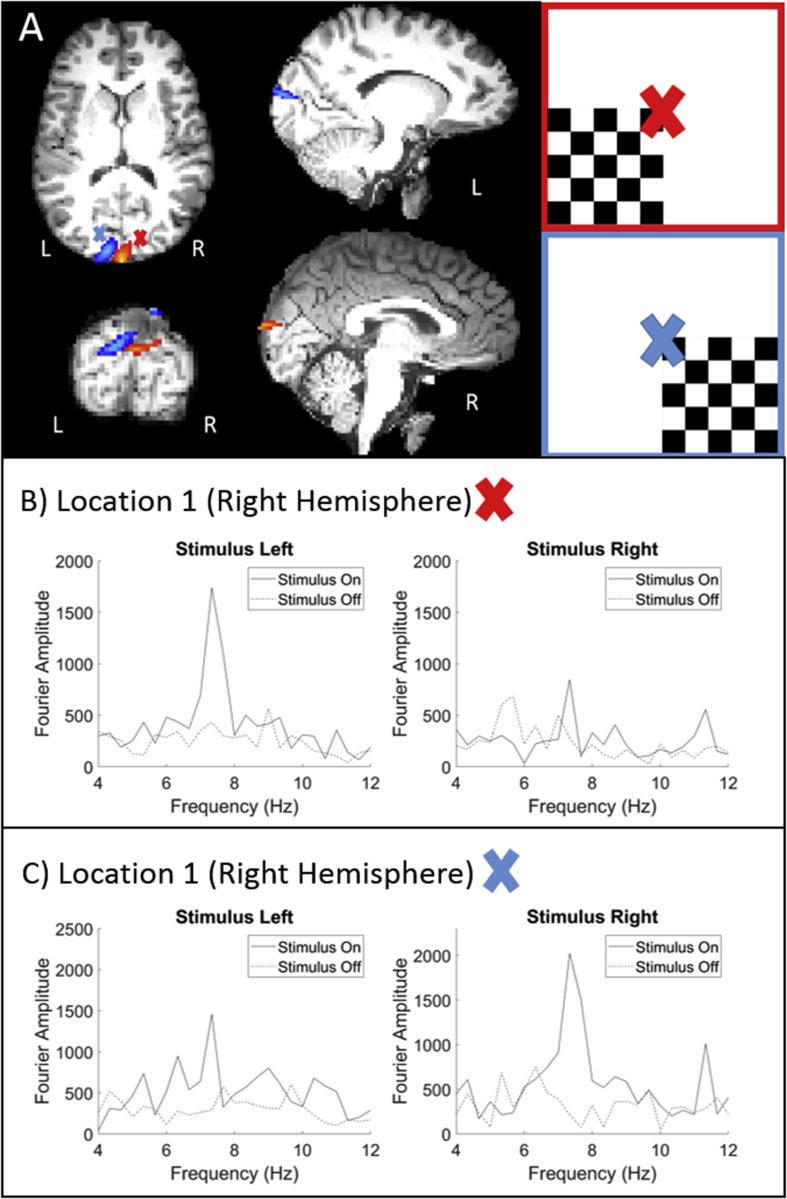
A) Pseudo T-stat images produced from the cases where the stimulus was in the left visual field (red cross, red overlay, subject view shown in red inset) or the right visual field (blue cross, blue overlay, subject view shown in blue inset). The images were thresholded between 1.5 and 1.8 and 1.1 and 1.6 for the red and blue images respectively. B) The Fourier transforms of virtual electrode time-courses compared during stimulation and rest. The electrode was positioned at the peak of the red overlay and compared for the cases where the stimulus was on the left and on the right. C) Comparing Fourier transforms of virtual electrodes positioned at the peak of the blue overlay and compared for the cases where the stimulus was on the left and on the right.